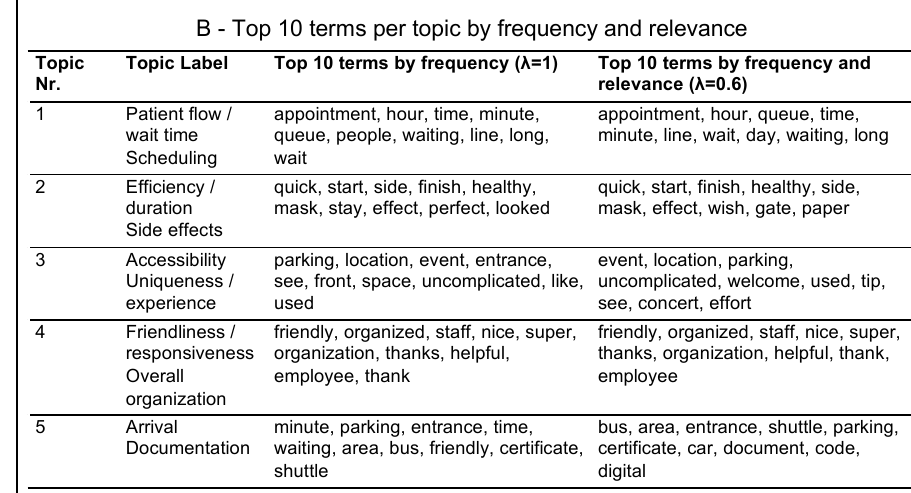
Figure 4. Four terms were featured in more than 10% (274/2740) of reviews: “organiza-